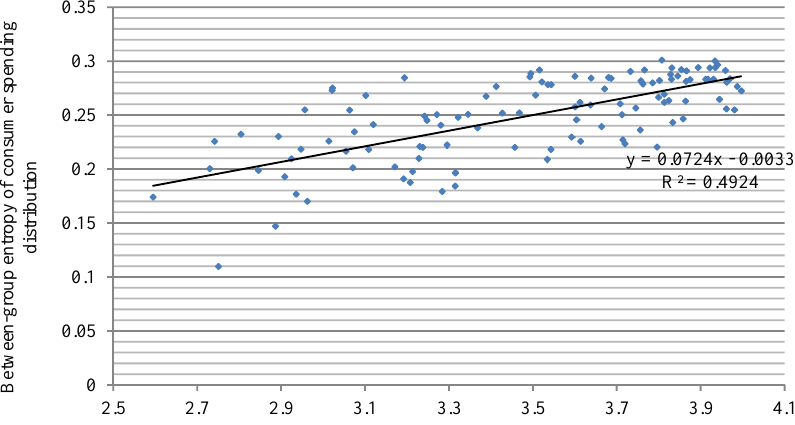
Source: own calculations based on ICP data. Figure 10. Linear regression for link "the absolute size of consumer spending — a measure of diversity of consumer spending (between-group entropy)" for 115 countries with lowest household spending